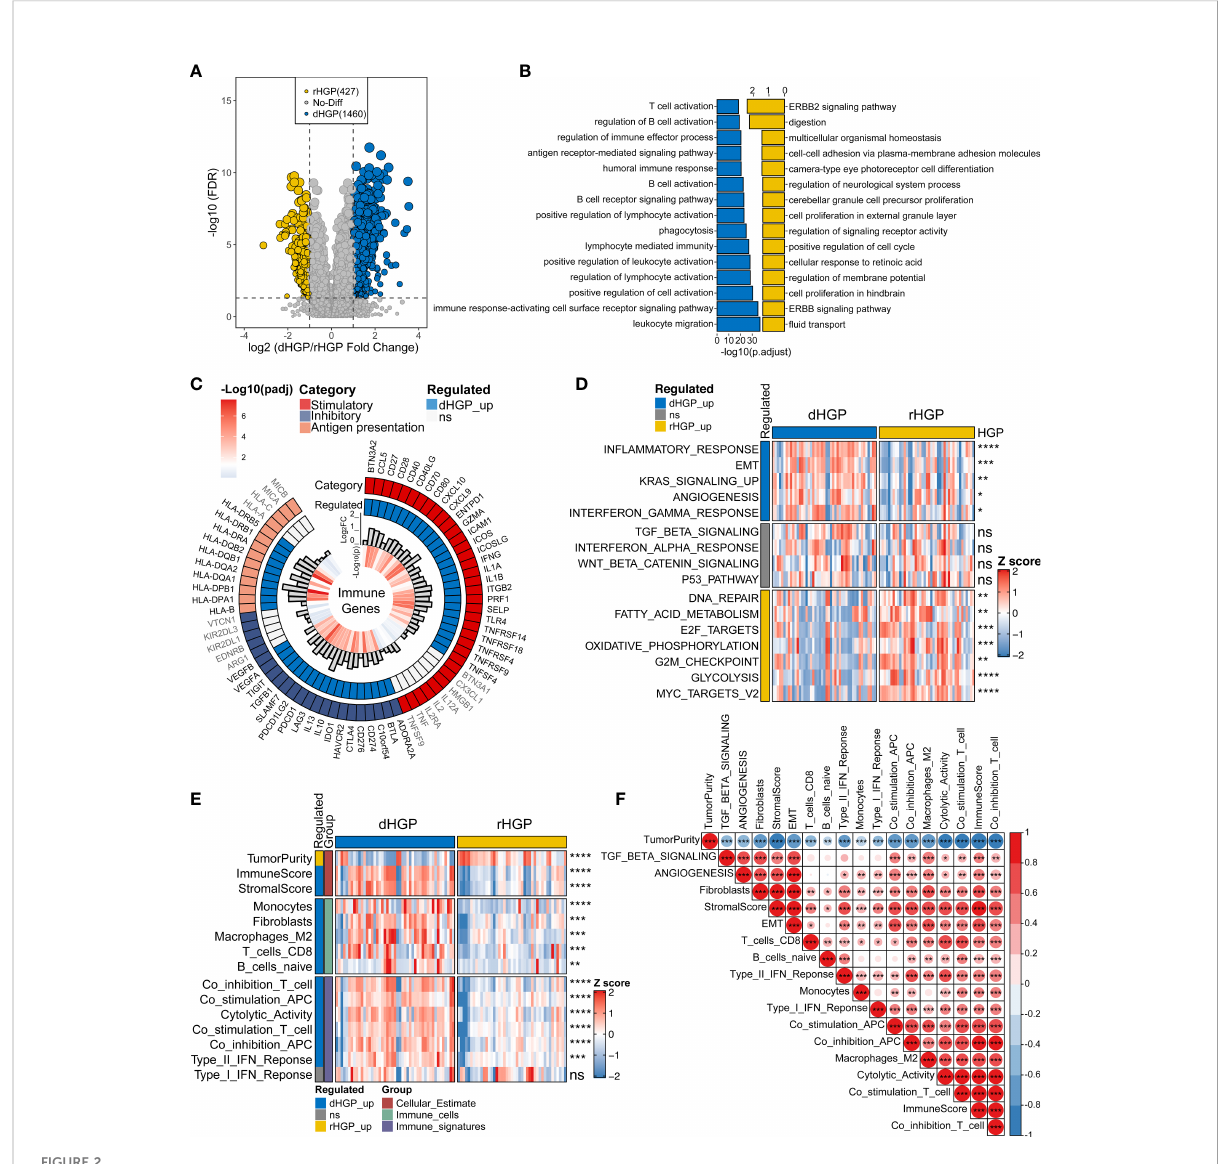
FIGURE 2 Comparison of the transcriptome landscapes between dHGP and rHGP liver metastases. (A) Volcano plot displaying 1460 up-regulated DEGs in the dHGP subgroup and 427 up-regulated DEGs in the rHGP subgroup (|LogFC| > 1, FDR < 0·05). (B) GO-BP enrichment analysis of the differentially expressed genes (FDR < 0·05). (C) Circos plot shows 55/72 up-regulated immune genes in the dHGP samples (LogFC > 0, FDR < 0·05). (D) Heatmap depicting the differences of HALLMARK pathways activity between dHGP and rHGP subgroups (Wilcoxon test. ns, p > 0·05; * p < 0·05; ** p < 0·01; *** p < 0·001; **** p < 0.0001). Rows represent GSVA scores of HALLMARK pathways, and columns represent samples. (E) Heatmap depicting the differences between two subgroups in TIME-relevant molecular signatures were linked to cellular estimates, immune cells and immune signatures (Wilcoxon test. ns, p > 0·05; ** p < 0·01; *** p < 0·001; **** p < 0.0001). Rows represent ssgsea scores of TIME- relevant molecular signatures and columns represent samples. (F) Correlations between selected HALLMARK pathways activity and TIME- relevant molecular signatures (Spearman correlation analysis. * p < 0·05; ** p < 0·01; *** p <